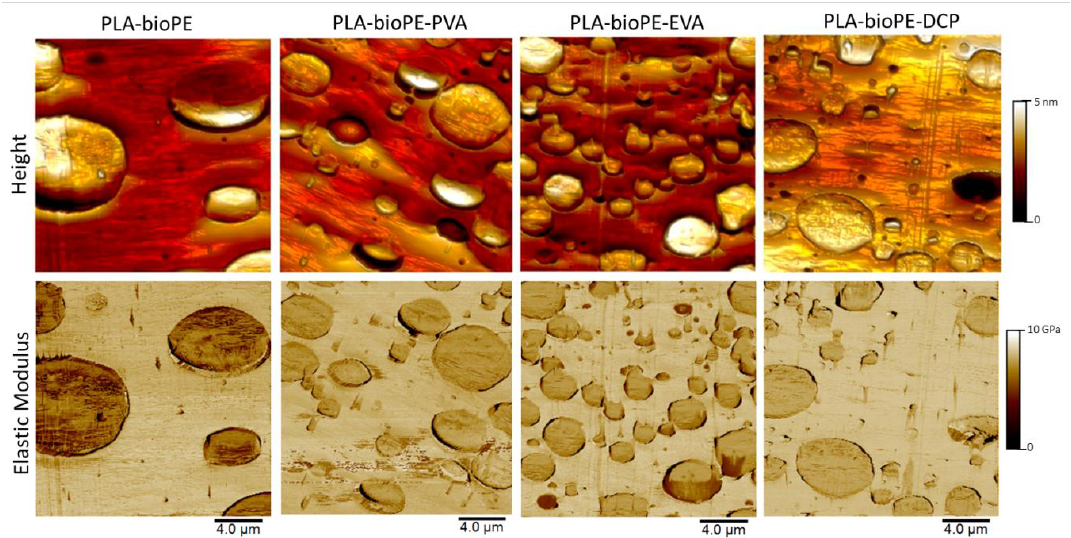
Figure 8. Height (superior) and elastic modulus (inferior) Atomic Force Microscopy maps obtained by Atomic Force Microscopy with PeakForce Quantitative Nanomechanical Mapping (AFM-QNM) on PLA-bioPE and PLA-bioPE blend compatibilized with PVA, EVA, and DCP.